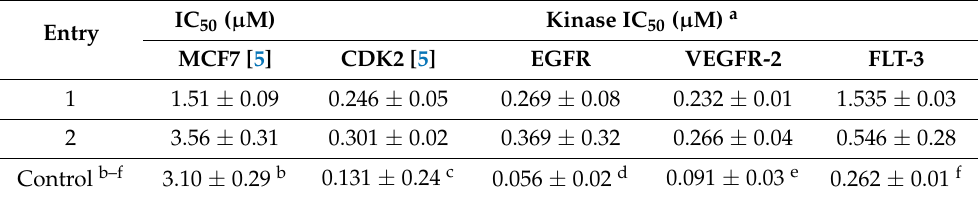
Table 1. Inhibitory activities of Compounds 1 and 2 against MCF7 cell lines, CDK2, EGFR, VEGFR-2 and FLT-3 protein